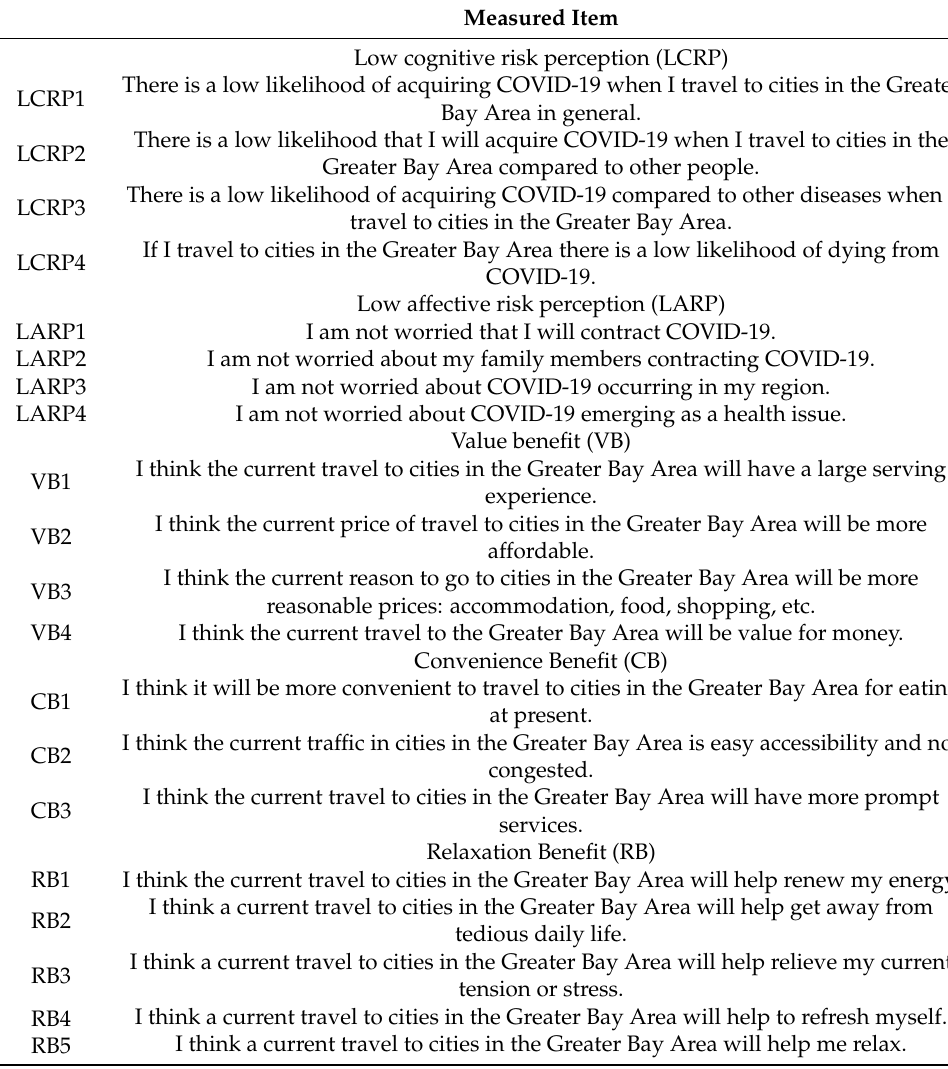
Table 1. Measurement scales.